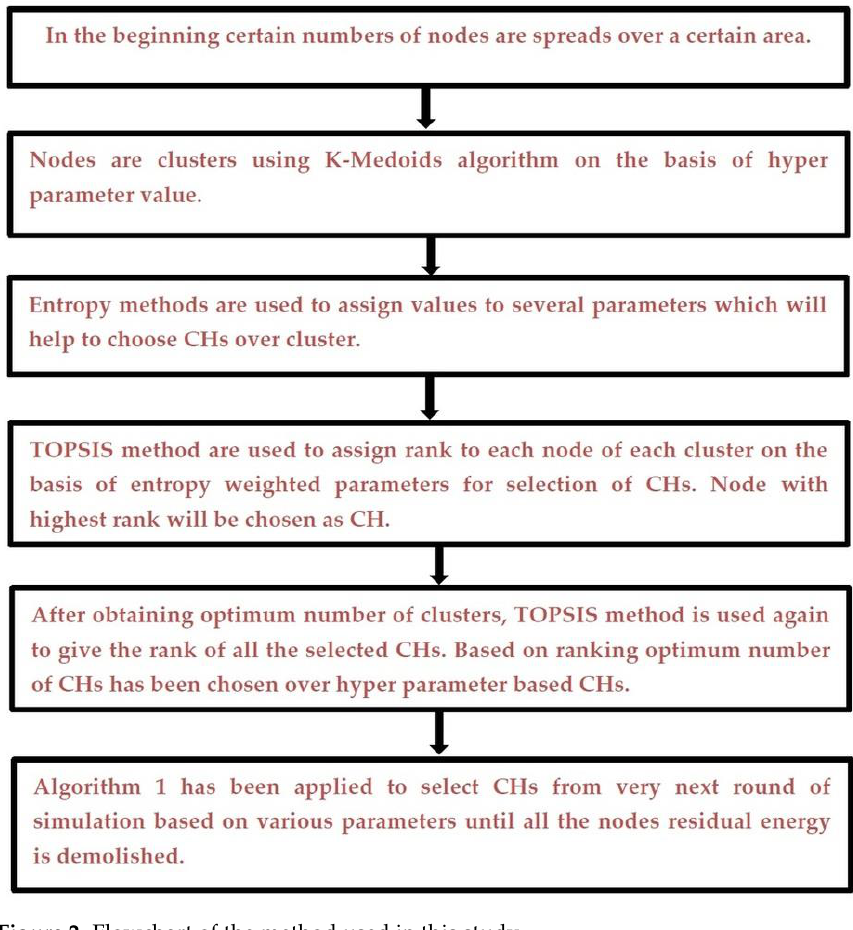
Figure 2. Flowchart of the method used in this study .